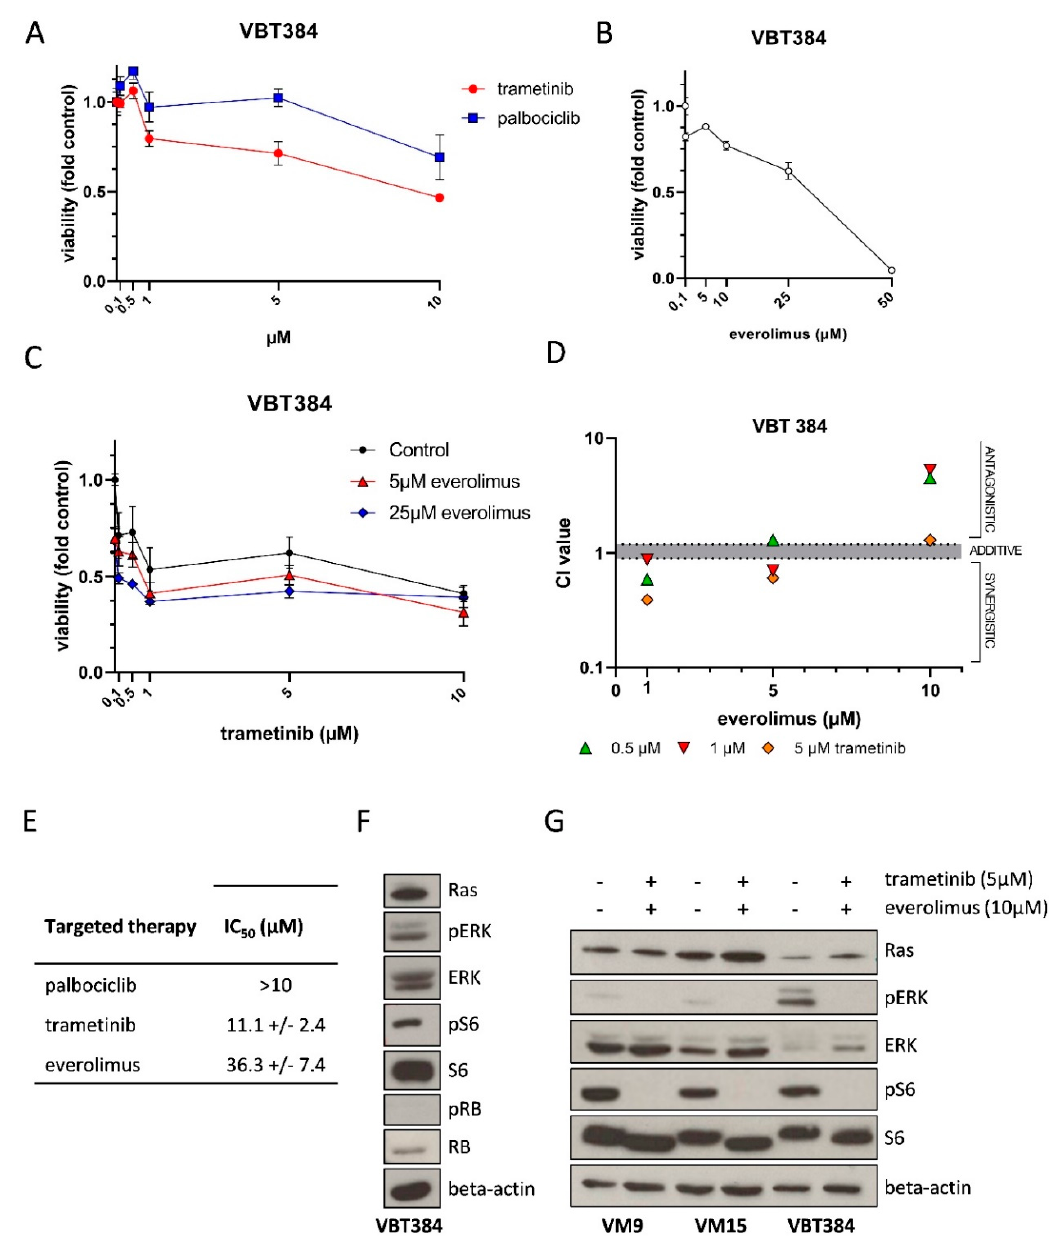
Figure 5. Sensitivity of patient-derived PDLMM cells to anti-cancer compounds and pathway activation. VBT384 cells were exposed to trametinib, palbociclib ( A ), everolimus ( B ) or indicated combinations ( C ) in the indicated concentrations for 72 h. Cell viability was measured by Cell-titer glo assay. Depicted results represent triplicates. Combination indexes from the experiment indicated in C were calculated according to the Chou-Talay method ( D ). IC 50 values calculated for palbociclib, trametinib and everolimus in VBT384 cells ( E ). Western blot for detection of basal activation of mitogen-activated kinase (MAPK), PI3K, and RB-signaling in VBT384 cells as indicated ( F ). Western blot of melanoma cell models (VM9, VM15) and patient-derived VBT384 cells for indicated proteins and phosphorylations upon trametinib and everolimus combination treatment for six hours before protein isolation ( G ).